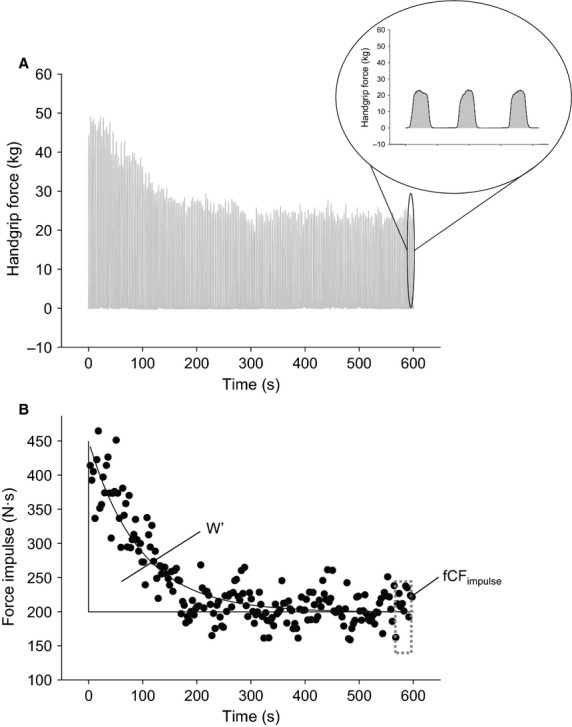
Force output during the fCFimpulse test for a representative participant. (A) Raw handgrip force tracing. Inset shows three contractions (shading indicates computation of the force impulse as the AUC). (B) Force impulse. Each dot represents the AUC of a single contraction. Dashed box indicates that the curve fit was used to calculate the average force impulse during the last 30 sec of the test; this value is the fCFimpulse. The area between the fCFimpulse and the curve fit is the W′. fCF, forearm critical force; AUC, area under the curve.